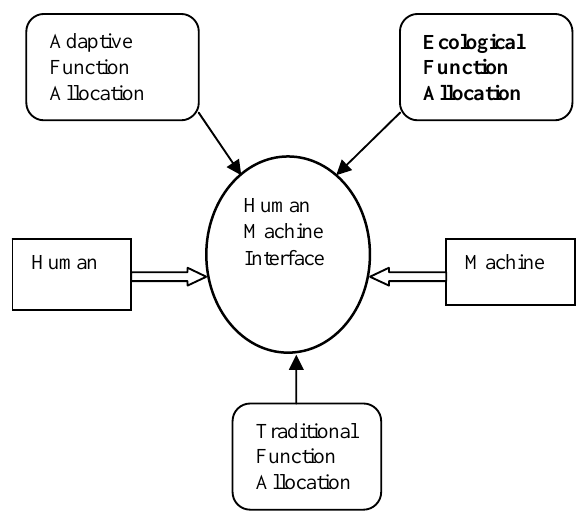
Fig. 1. Function allocations in human-machine interface design